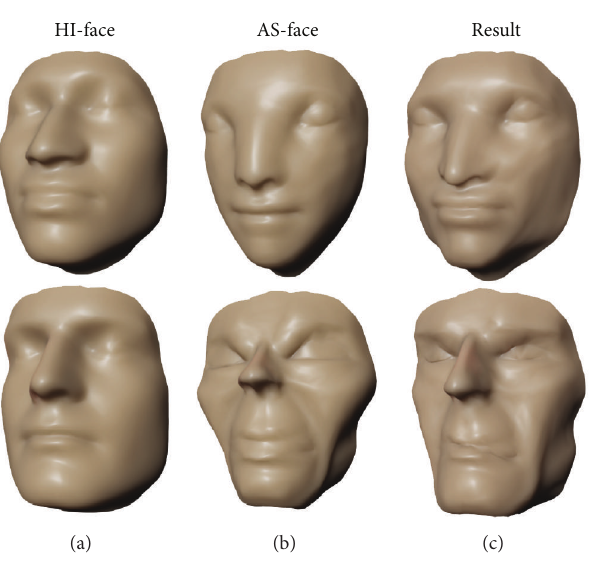
Figure 6: 3D geometric views of two resultant artistic faces (the slider value is set to 0.5).